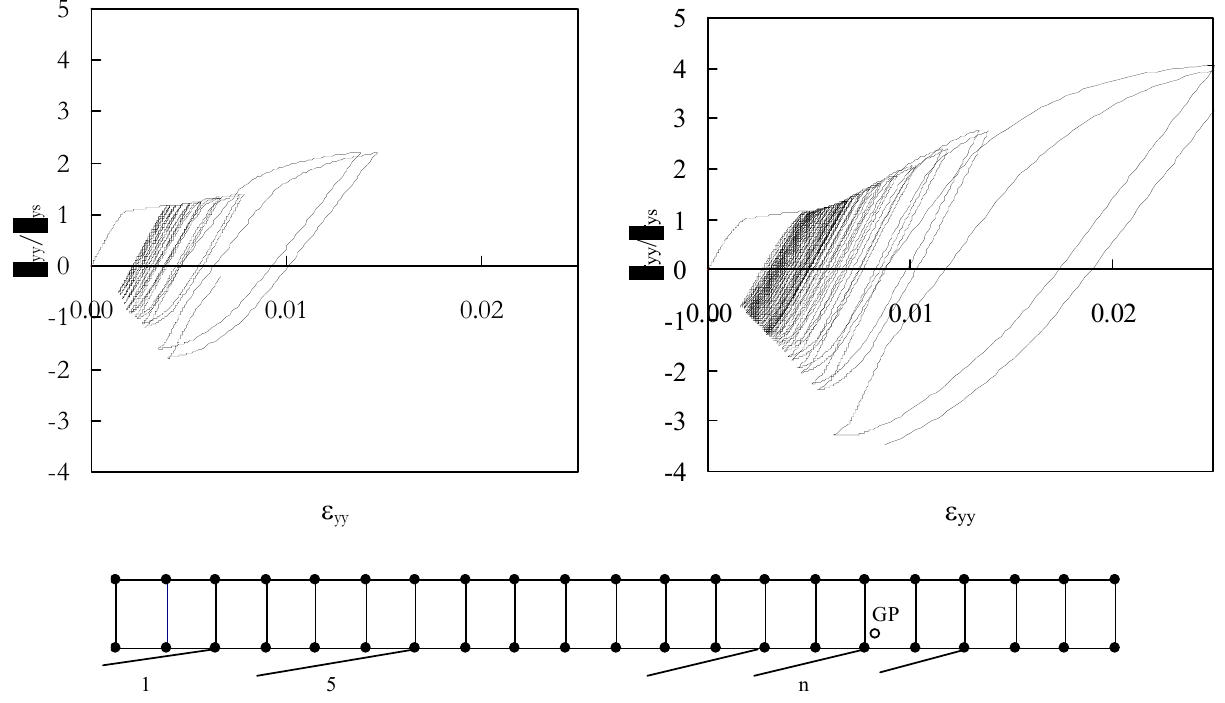
Figure 2: Influence of finite element mesh on stress-strain curves. a) Mesh M32. b) Mesh M8. c) Position of the Gauss point. (a=10mm; W=30 mm;  max =47.5 MPa;  min =0.8